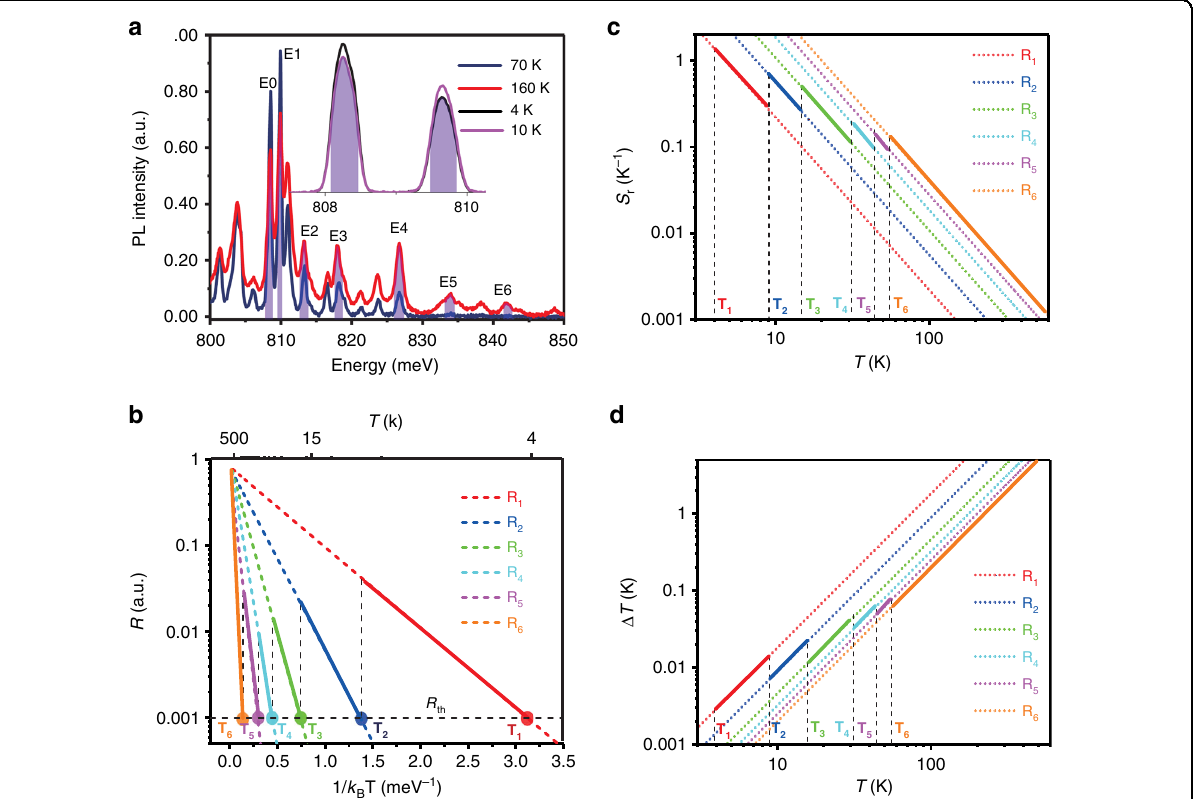
Fig. 2 Construction of intensity ratios and measurement strategy. a Spectra between 800 meV (1.55 μ m) and 850 meV (1.46 μ m) showing key spectral peaks selected to construct PLIRs; b ) Temperature dependence of various PLIRs, R 1 through R 6 , with both temperature (top axis) and inverse temperature scaled by the Boltzmann constant (low axis). The segment with solid lines indicates the range of temperature where a particular R i is used, because of larger sensitivity (see c ). c Sensitivities and d temperature resolution for the six constructed PLIRs, R 1 – R 6 , respectively. The segments with solid lines indicate the sensitivities and the temperature resolutions corresponding to R i ’ s used for sensing consistent with color code and convention in ( b